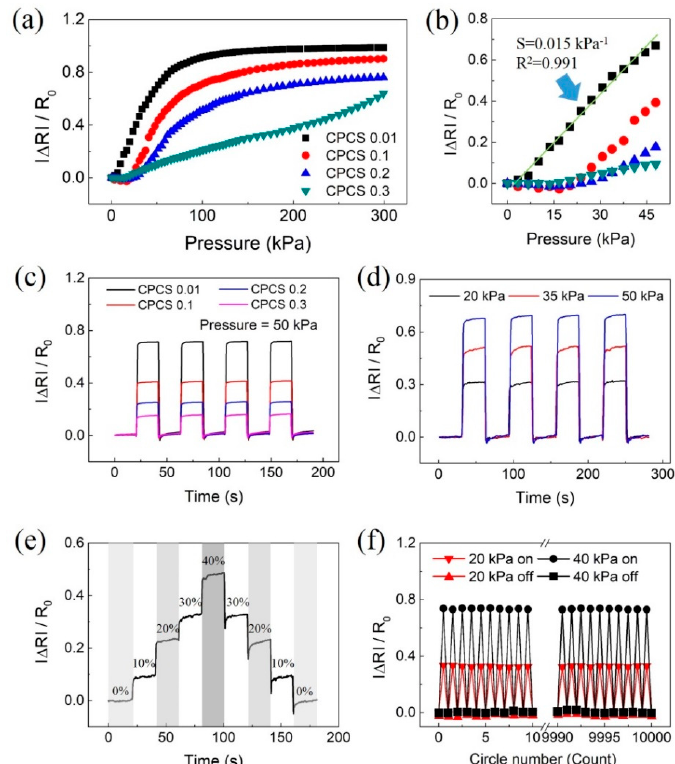
Figure 8. Performance evaluation of flexible pressure sensors based on CPCS. ( a,b ) The measured relative resistance changes as a function of the applied pressure for sensors with different CNT concentrations. The sensor based on CPCS 0.01 showed the highest sensitivity of 0.015 kPa − 1 and a linearity of 0.991. ( c ) Measurement results under repeated loading–unloading tests with different CNT concentrations at 50 kPa pressure. ( d ) With different pressures at the sensor based on CPCS 0.01. ( e ) Dynamic responses of the pressure sensor at continuously increasing and decreasing pressures. ( f ) Reliability test results: black squares ( ■ ) and red triangles ( ▲ ) show changes in resistance when released, and black circles ( ● ) and red inverted triangles ( ■ ) show changes in the resistance when pressed.